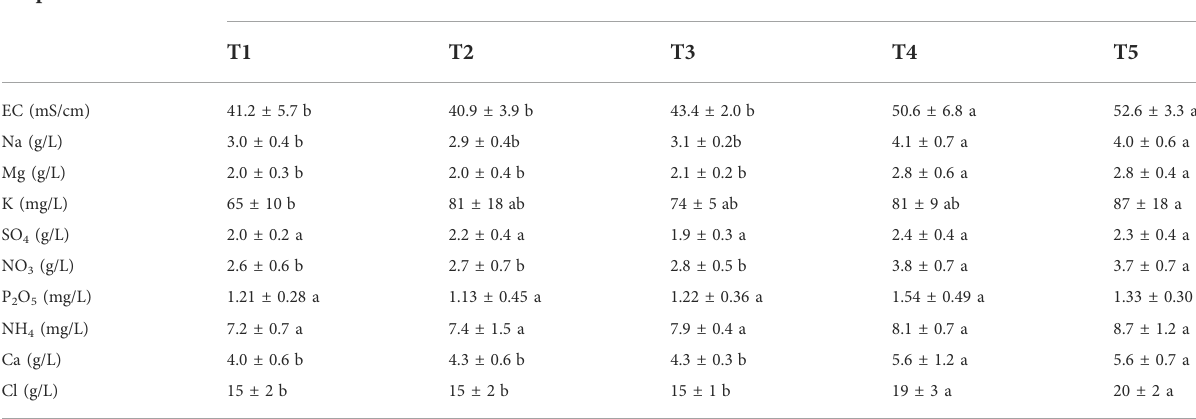
TABLE4EC,salts,andnutrientscontentsofleachateofSidiElMokhtarsoilfordifferenttreatments.Inalineseries,samelettersindicatenosigni fi cant differences among treatments ( p < 0.05, S-N-K ‘ s